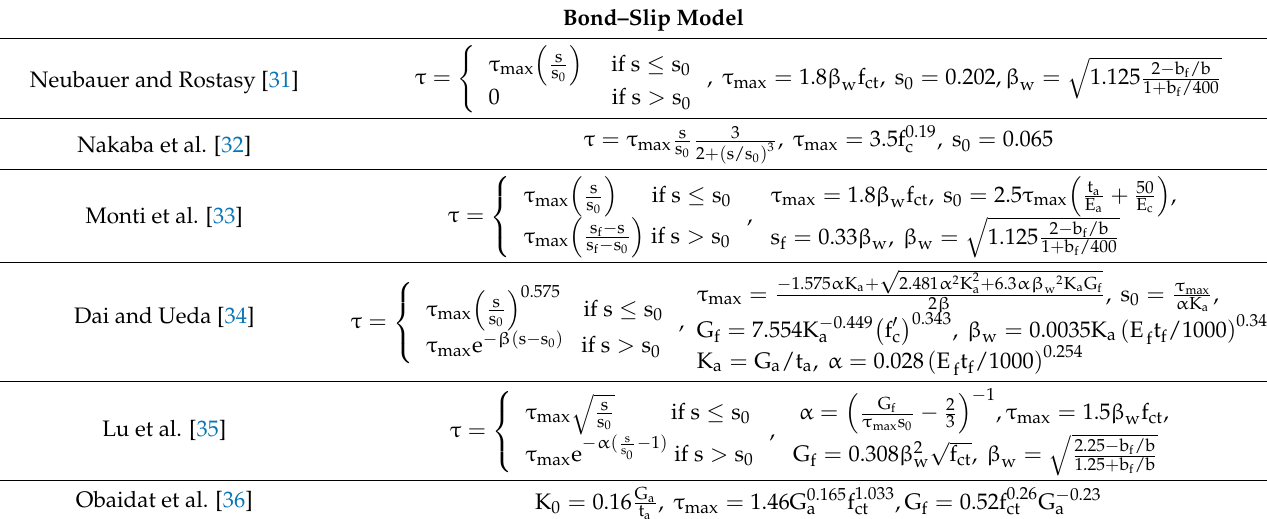
Table 5. Existing bond–slip models.